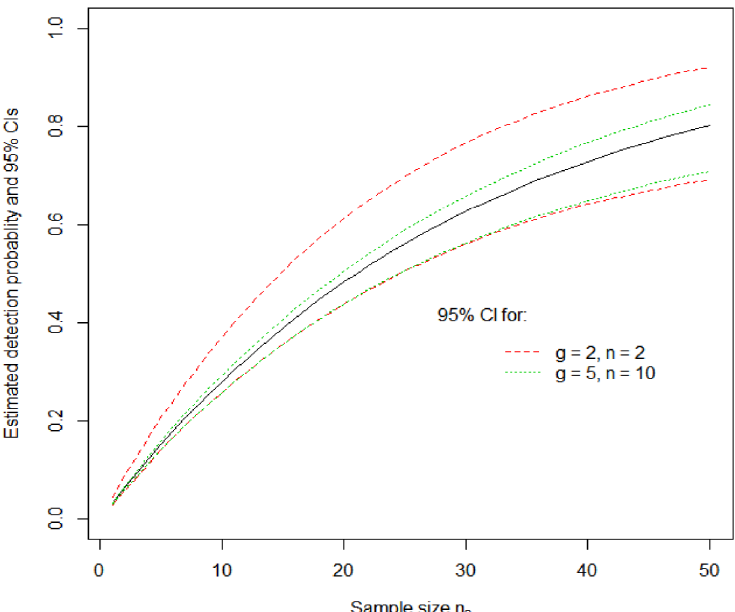
Fig. 8. Estimated detection probability and 95% con fi dence interval versus sample size n 2 for cases A and B. The true detection probability is plotted as the solid (black)